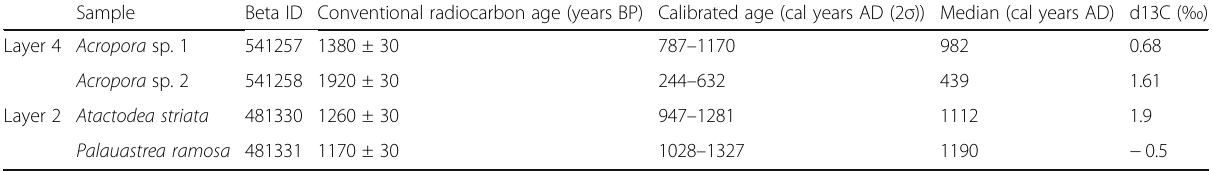
Table 2 Radiocarbon ages of bioclasts collected from the trench wall Sample